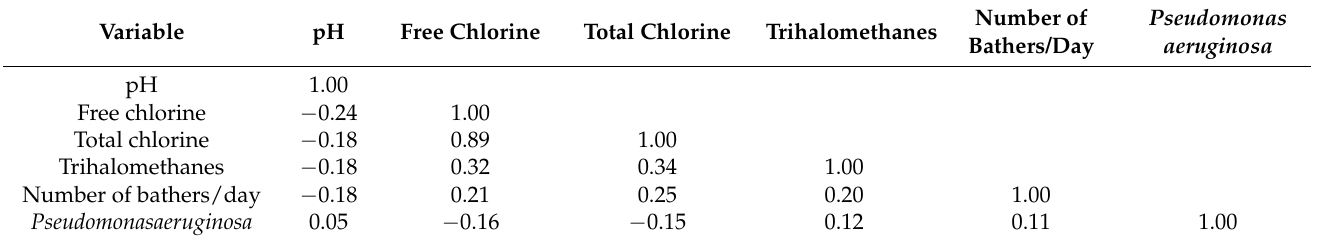
Table 2. Coefficients of correlation between chemical parameters, the number of bathers per day, and Pseudomonas aeruginosa bacteria levels of analyzed pool waters treated with chlorination (Cl) disinfection methods and represented by the nonparametric Kendall–Tau correlation test (N = 360; 90 samples × four sampling points). Statistically significant correlations ( p < 0.05) are presented in bold-type